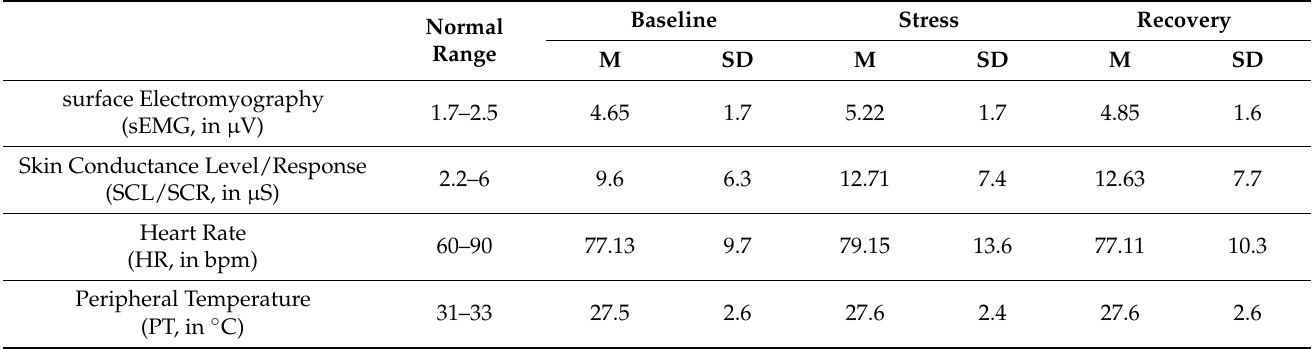
Table 3. Average values obtained by the patients in the Psychophysiological Stress Profile (PSP). Normal Range